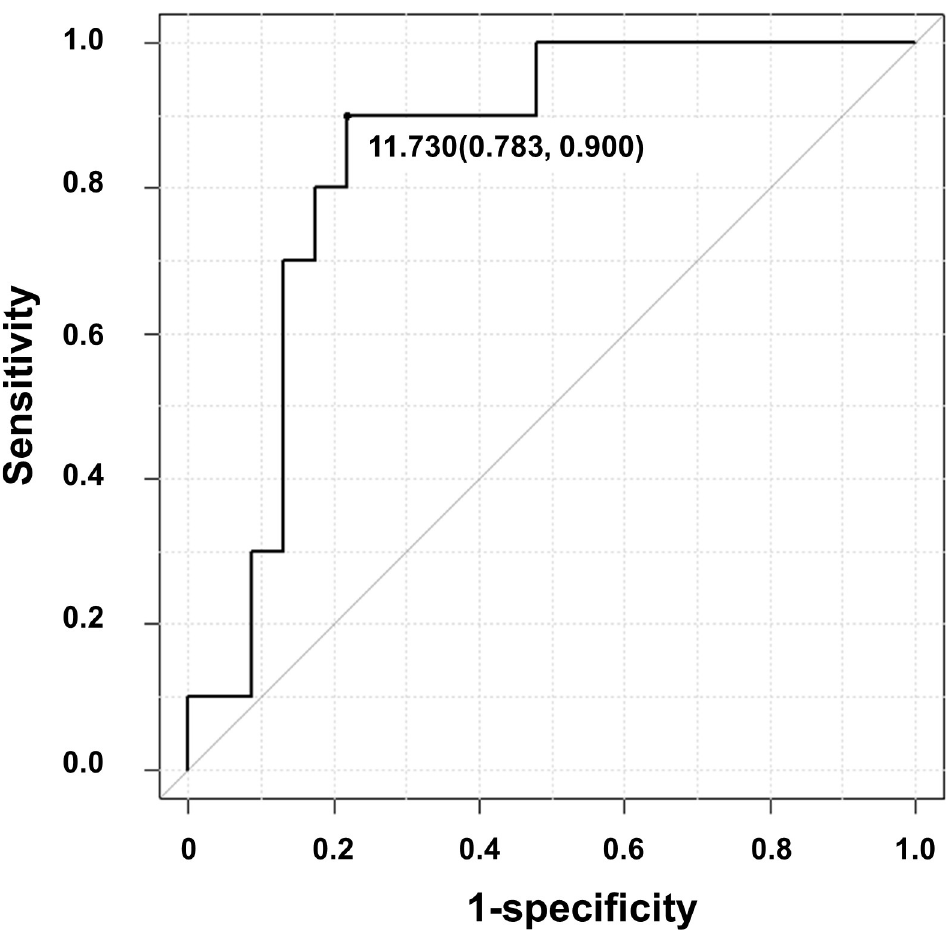
Fig 4. Receiver operating characteristic curve for the predictive value of sLR11 for PH. A cut-off sLR11 level of 11.7 ng/ml offered optimal differentiation between patients with and without PH (AUC = 0.85, 95%CI = 0.72–0.98).